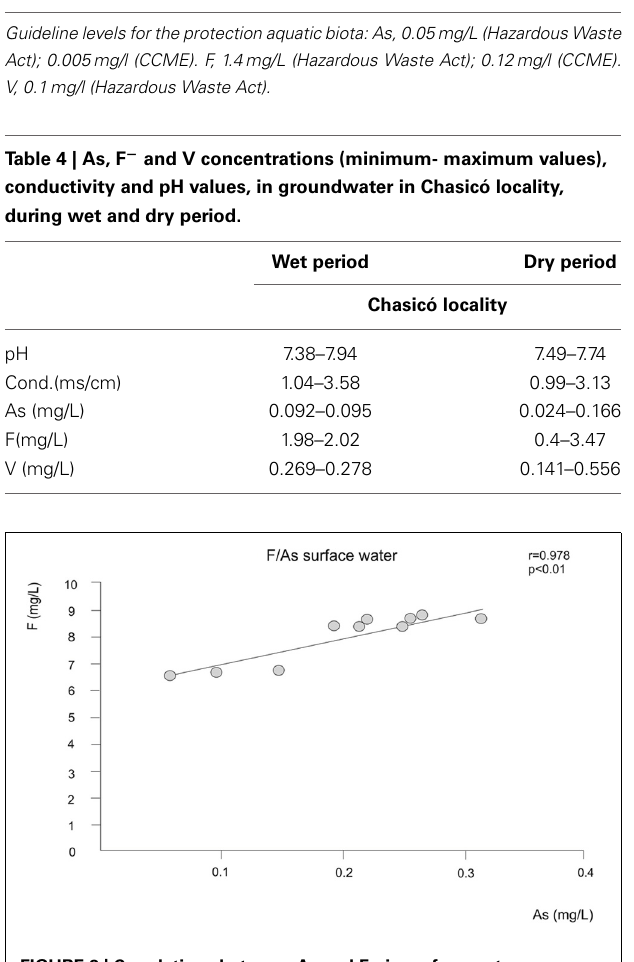
FIGURE 2 | Correlations between As and F − in surface water.